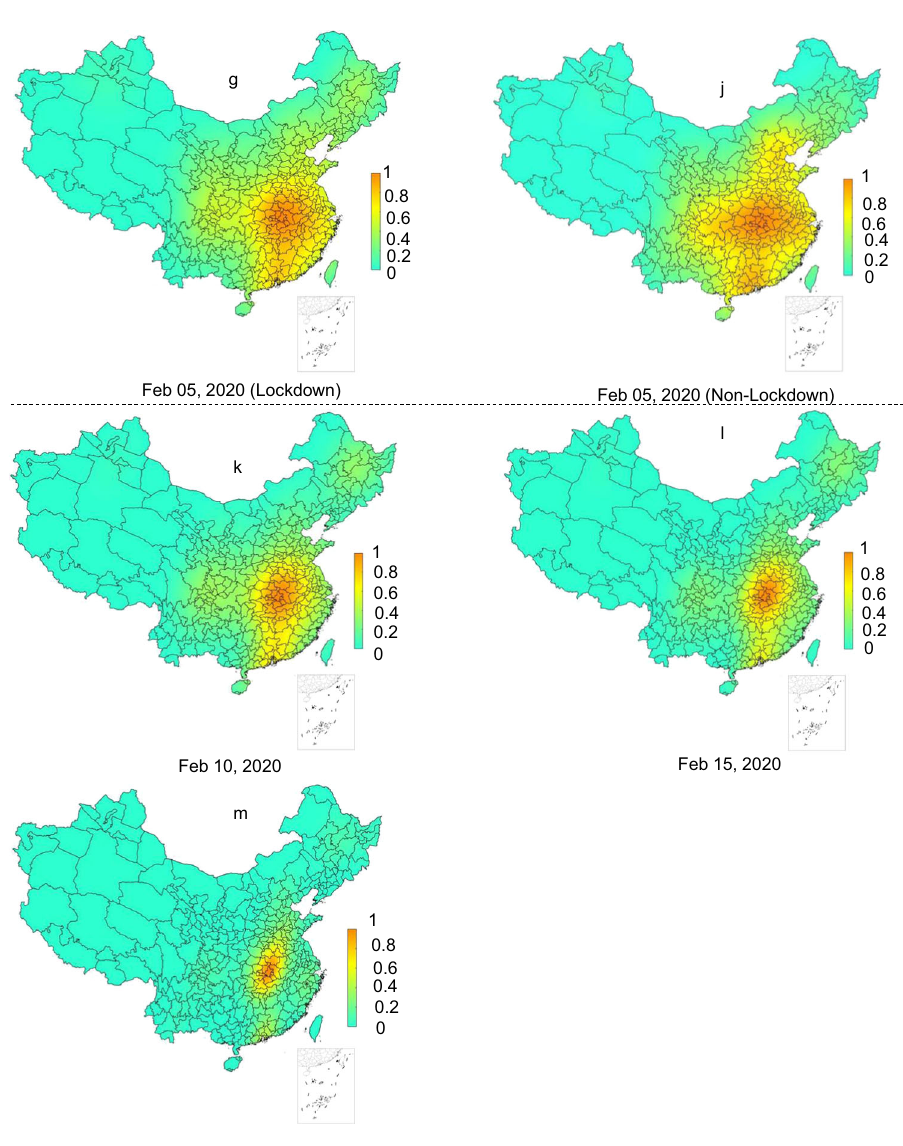
Fig. 2 Predicted risk of COVID-19 symptom onset across 347 Chinese cities. a – d The predicted onset risk before the date of Wuhan lockdown. e – m The predicted onset risk after the date of Wuhan lockdown under two scenarios, i.e., with ( e – g , k – m ) and without ( h – j ) Wuhan lockdown. The predicted COVID-19 symptoms onset risk were generated by the extended WKDE model, by using historical con fi rmed cases and inter-city human mobility data. The historical con fi rmed cases data included the locations at which these cases had a period of study prior to the diagnosis. The predictions under two scenarios were made by differing the human mobility intensity from Wuhan to other cities after the date of the Wuhan lockdown. Under the lockdown scenario, the outward human fl ows from Wuhan were regarded as not increasing the onset risk of other cities, due to the dramatic decrease in human mobility intensity, together with strict quarantine measures. Under the non-lockdown scenario, the human mobility intensity was estimated based on that of the corresponding time period in 2019 (see Methods section for